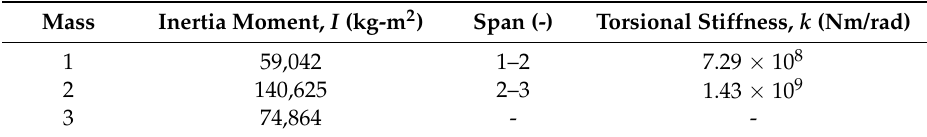
Table 5. Shaftline mass-spring modelling properties.